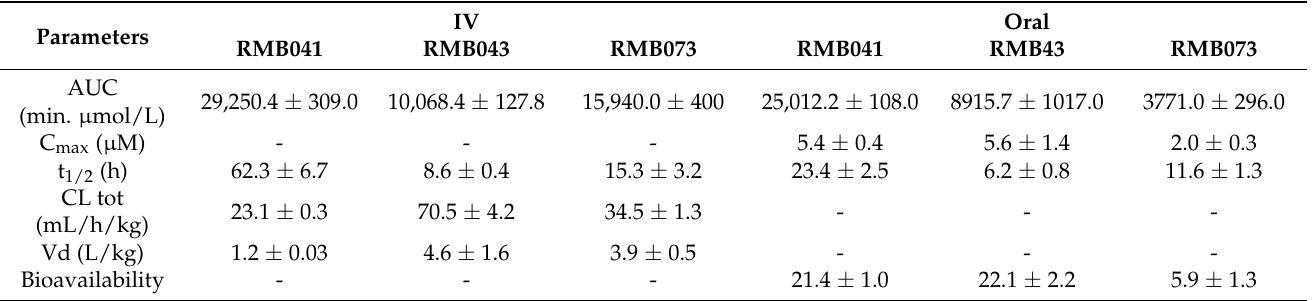
Table 3. Pharmacokinetic evaluation in male C57BL mice using doses of DQ derivatives of 20